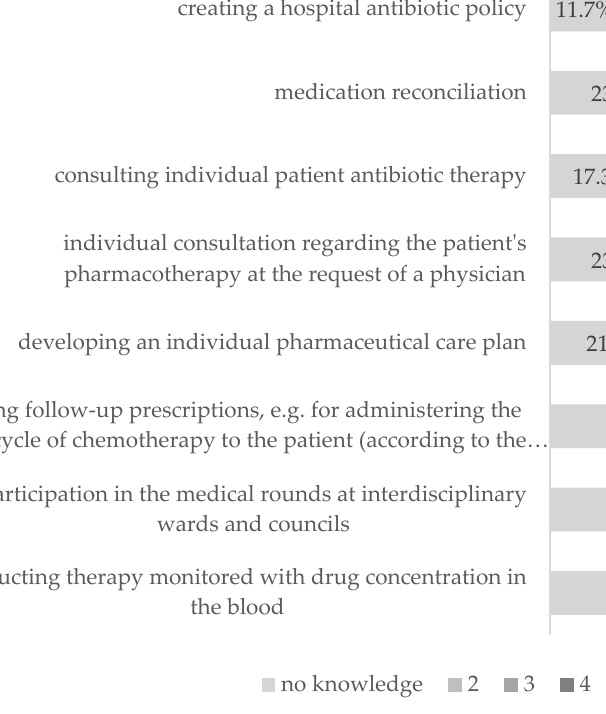
Figure 9. Knowledge of the individual tools of clinical pharmacy.